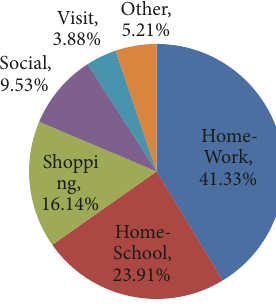
Figure 4: Journey frequency.